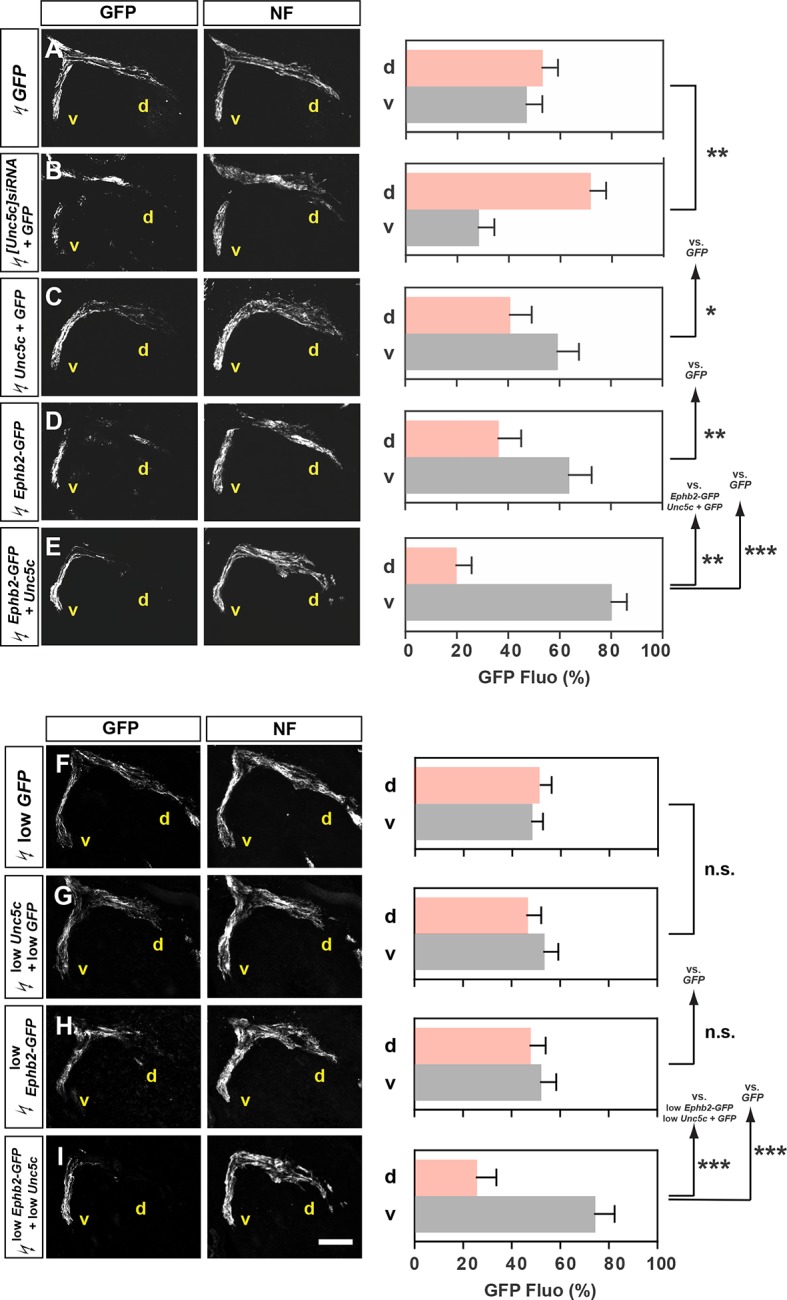
Co-operation between Unc5c and EphB2 receptors in LMC trajectory selection. (A–E) GFP and neurofilament detection in the limb nerve branches in the crural plexus of embryos electroporated with the following expression plasmids and siRNAs: GFP (A), [Unc5c]siRNA and GFP (B), Unc5c and GFP (C), EphB2-GFP (D), or EphB2-GFP and Unc5c (E). Quantification of GFP signals in all electroporation experiments expressed as, respectively, percentage in dorsal and ventral limb nerves (GFP Fluo [%]). n = 5 embryos. (F–I) GFP and neurofilament detection in the limb nerve branches in the crural plexus of embryos electroporated with the following expression plasmids with 20% of normal concentration: low GFP (F), low Unc5c and low GFP (G), low EphB2-GFP (H), or low EphB2-GFP and low Unc5c (I). Quantification of GFP signals in all electroporation experiments expressed as, respectively, percentage in dorsal and ventral limb nerves (GFP Fluo [%]). n = 5 embryos. See text for detailed description. d, dorsal; v, ventral; error bars = SD; *** = p<0.001; ** = p<0.01; * = p<0.05; n.s.= non significant; statistical significance computed using Mann-Whitney U test; All values (mean ± SD) can be found in Supplementary file 1B. Scale bar: 150 µm.